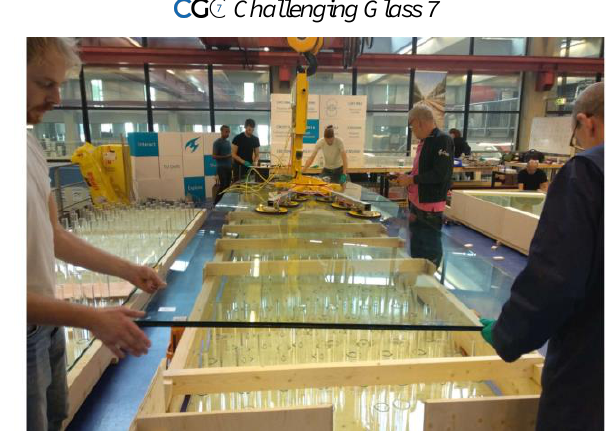
Fig. 12 placement of top panel.